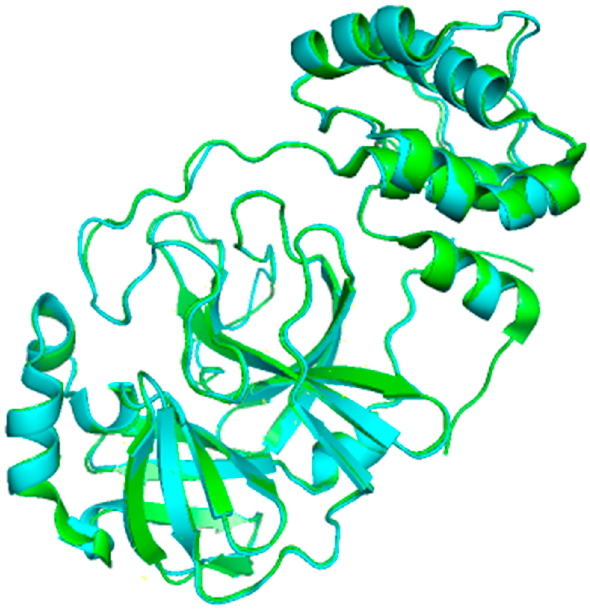
Figure 5. The superimpose of 3CLpro between SARS-CoV-2 (green colour, PDB ID: 7JPY) and SARS-CoV (cyan colour; PDB ID: 2BX4) structures with R.M.S.D value of 0.459 Å. It was visualized with PyMOL.